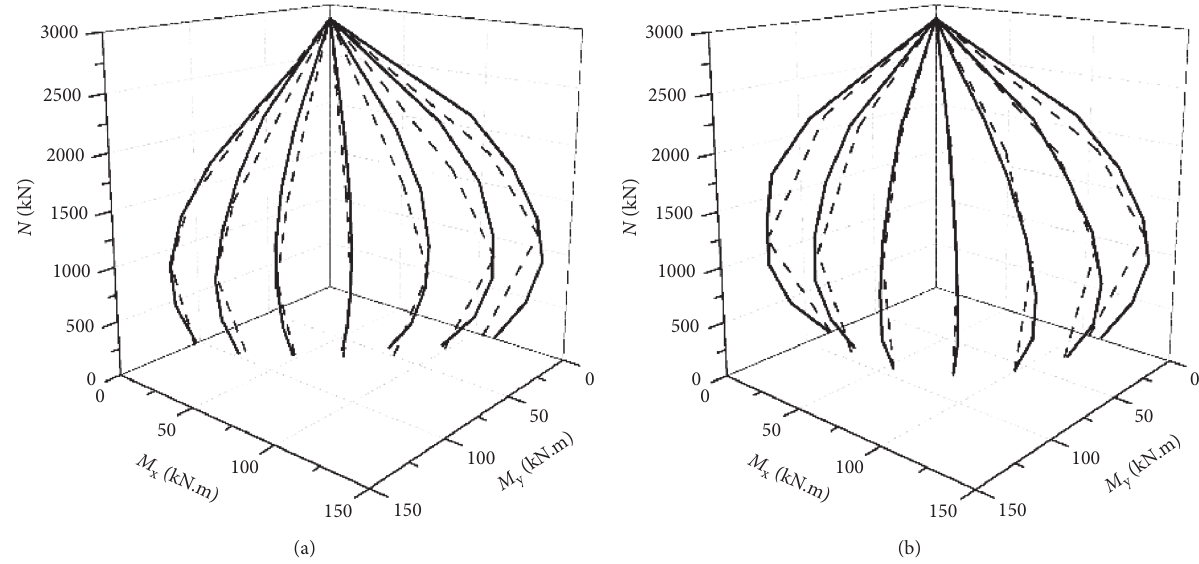
Figure 22: Verification of cross-sectional simplified N-M resistance model in loading angle ( − 90 ° –90 ° ). (a) Positive loading (0–90 ° ). (b) Negative loading ( − 90 ° ∼